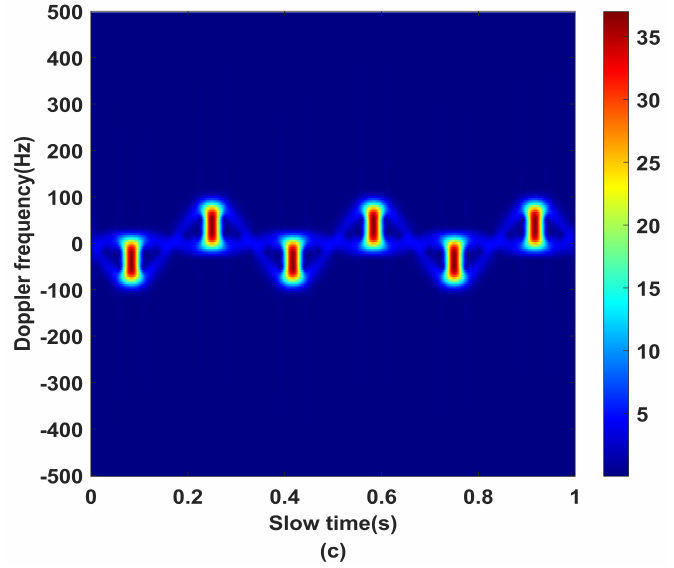
Figure 3. The echo of a single scatter in the time-frequency domain: ( a ) profile distribution, ( b ) phase distribution, ( c ) integrated echo